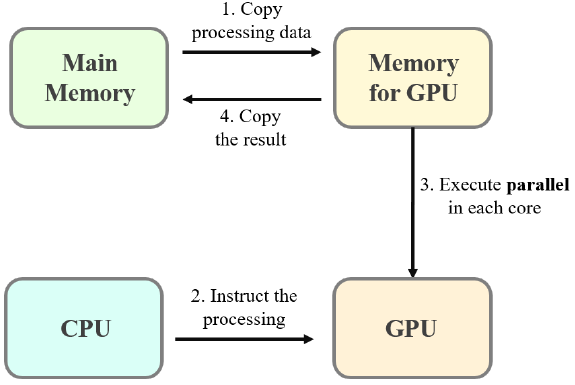
Figure 2. Processing flow on